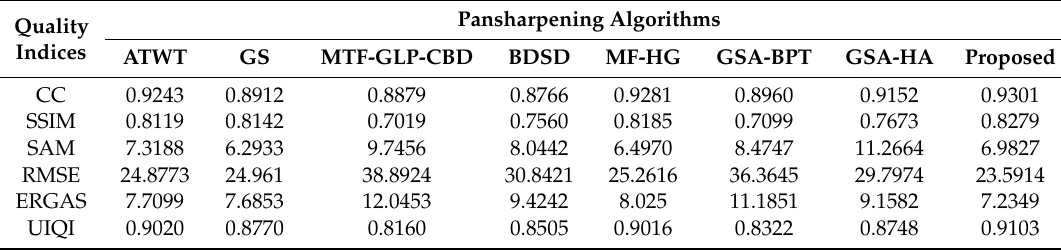
Table 2. Objective quantitative indices obtained by compared methods for degraded GeoEye-1 data set. Quality